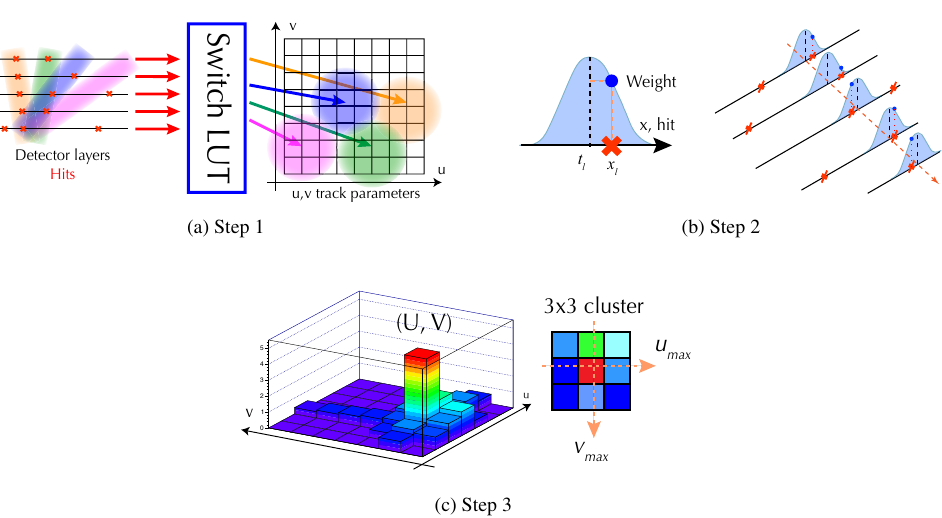
Figure 2: Processing steps of track reconstruction with the artificial retina algorithm.